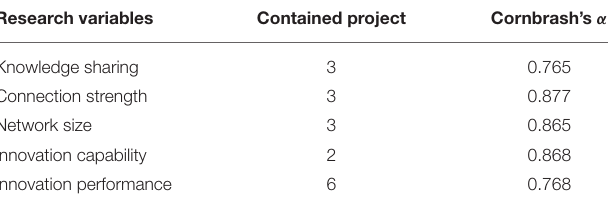
TABLE 5 | Combination validity and convergent validity.